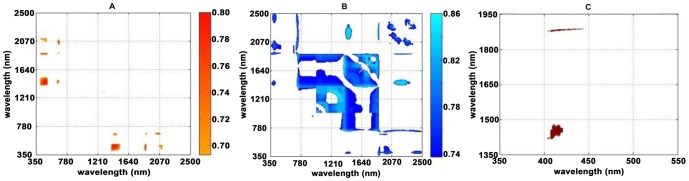
The 1∶1 relationship between the predicted and observed LEWT based on NDSIb (R1445, R487) for wheat before anthesis (A); the 1∶1 relationship between the predicted and observed LEWT based on NDSIa (R1714, R1395) for wheat after anthesis (B).